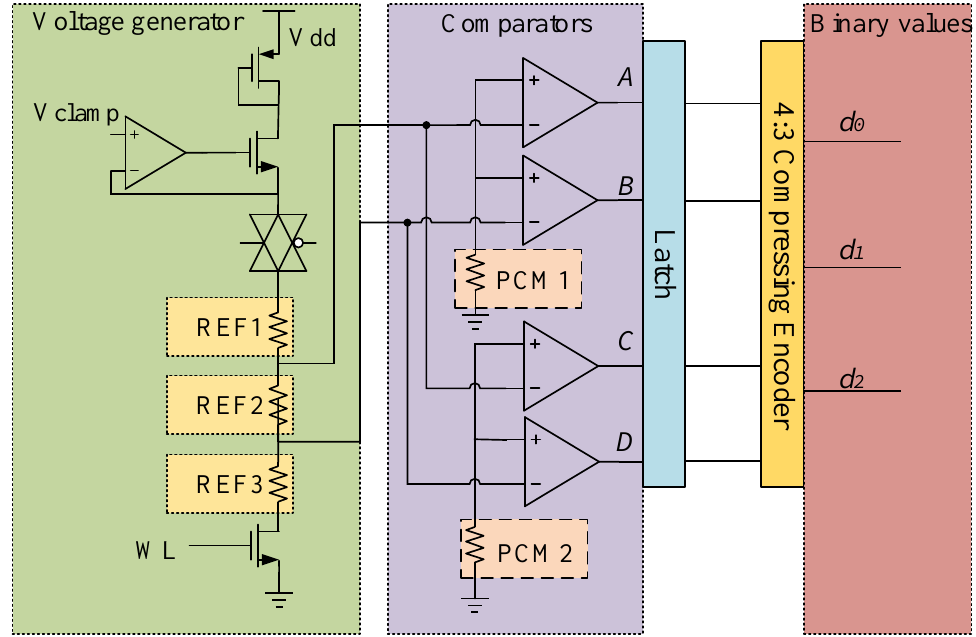
Figure 8. A schematic of the comparison readout circuit.